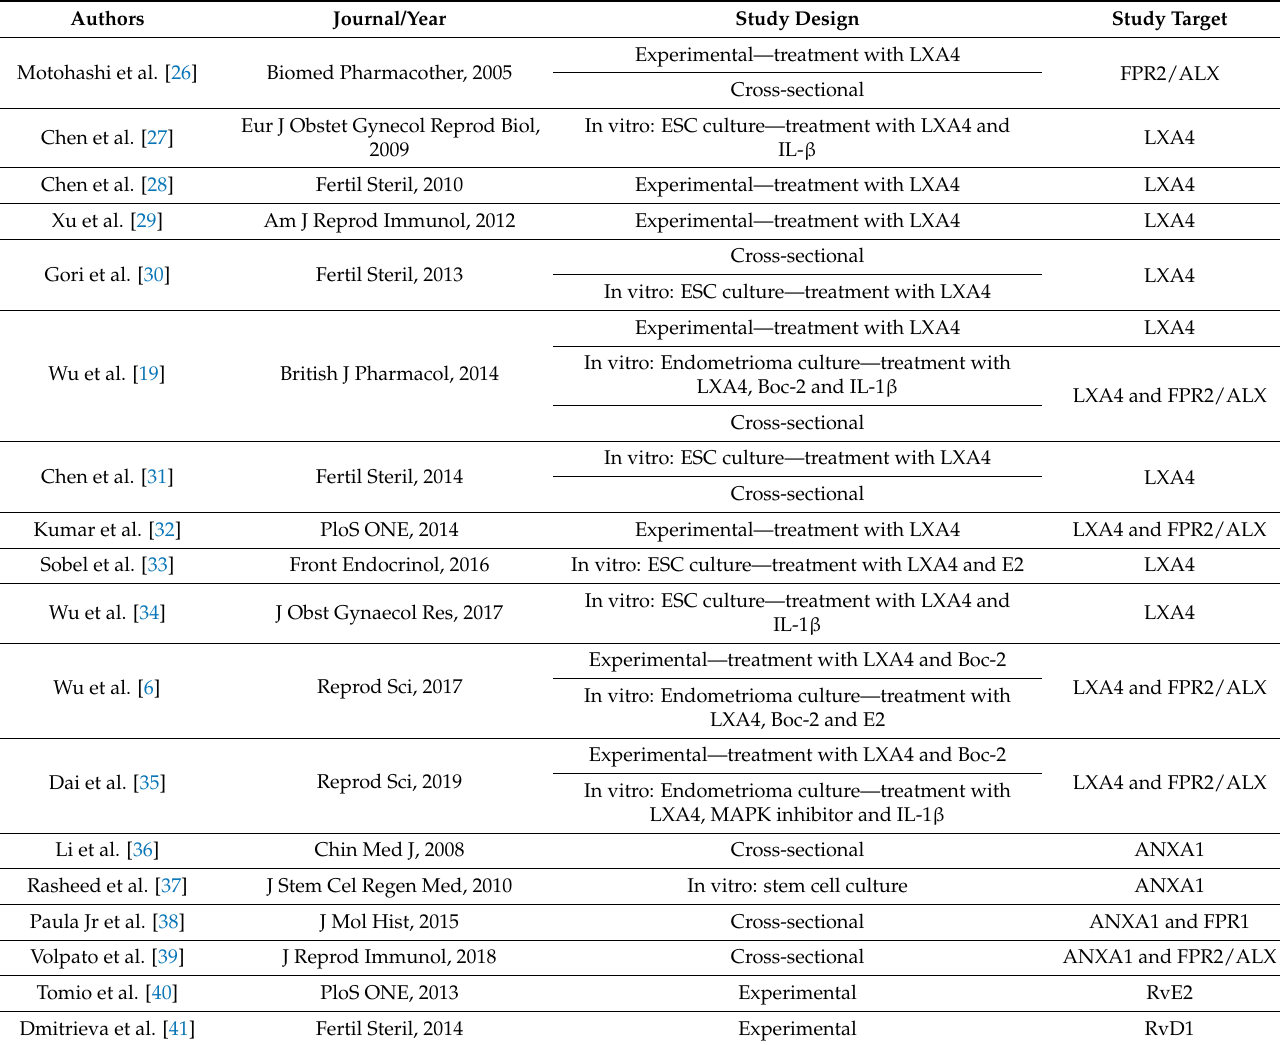
Table 2. Categorization of articles selected by the main authors, journal, design and study target. S ã o Jos é -SC—Brazil, 2021.